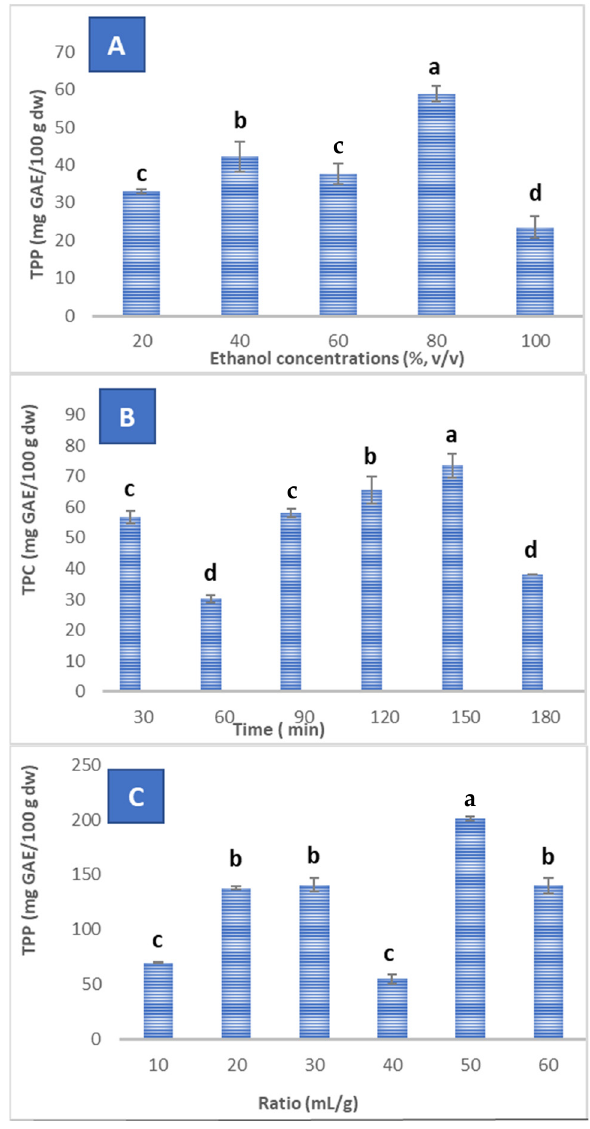
Figure 1. Influence of the ethanol concentration ( A ), time ( B ), and liquid/solid ratio ( C ) on the content of total phenolics in potato peel extracts. The mean of TPC assigned with different letters indicates significant differences ( p ≤ 0.05); those followed by the same letter are not significantly